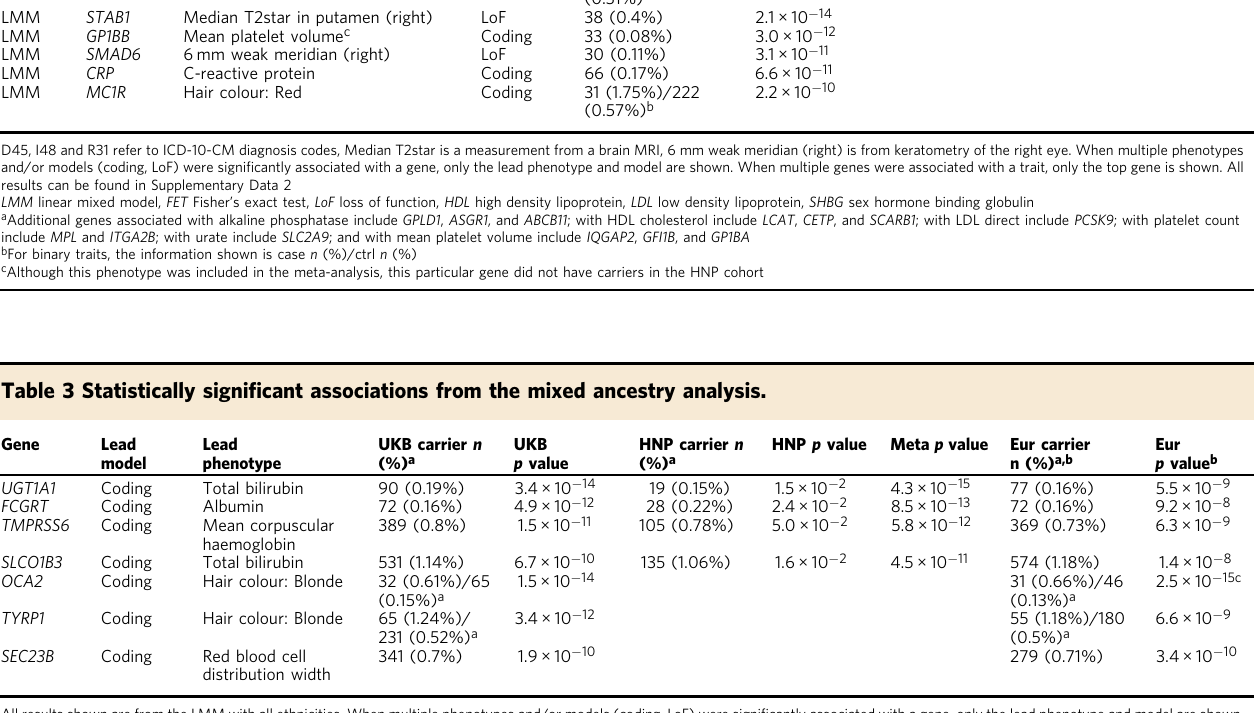
LoF CRP C-reactive protein Coding 66 (0.17%) 6.6×10 − 11 LMM MC1R Hair colour: Red Coding 31 (1.75%)/222 2.2×10 − 10 (0.57%) b D45, I48 and R31 refer to ICD-10-CM diagnosis codes, Median T2star is a measurement from a brain MRI, 6 mm weak meridian (right) is from keratometry of the right eye. When multiple phenotypes and/or models (coding, LoF) were signi fi cantly associated with a gene, only the lead phenotype and model are shown. When multiple genes were associated with a trait, only the top gene is shown. All